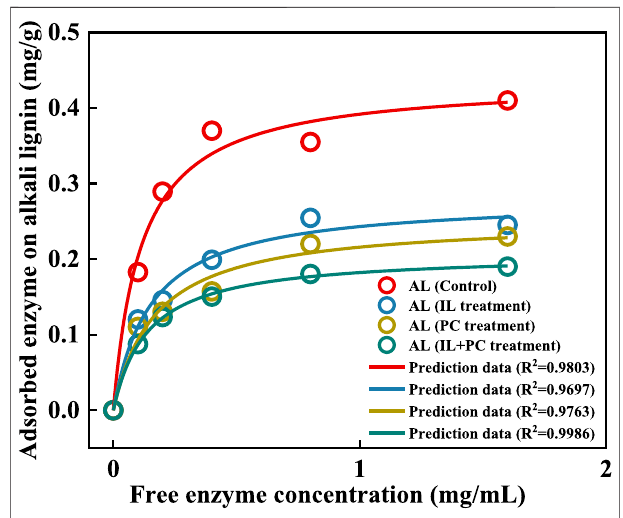
FIGURE 6 | Cellulase enzyme adsorption on alkali lignin before and after fungi treatment.